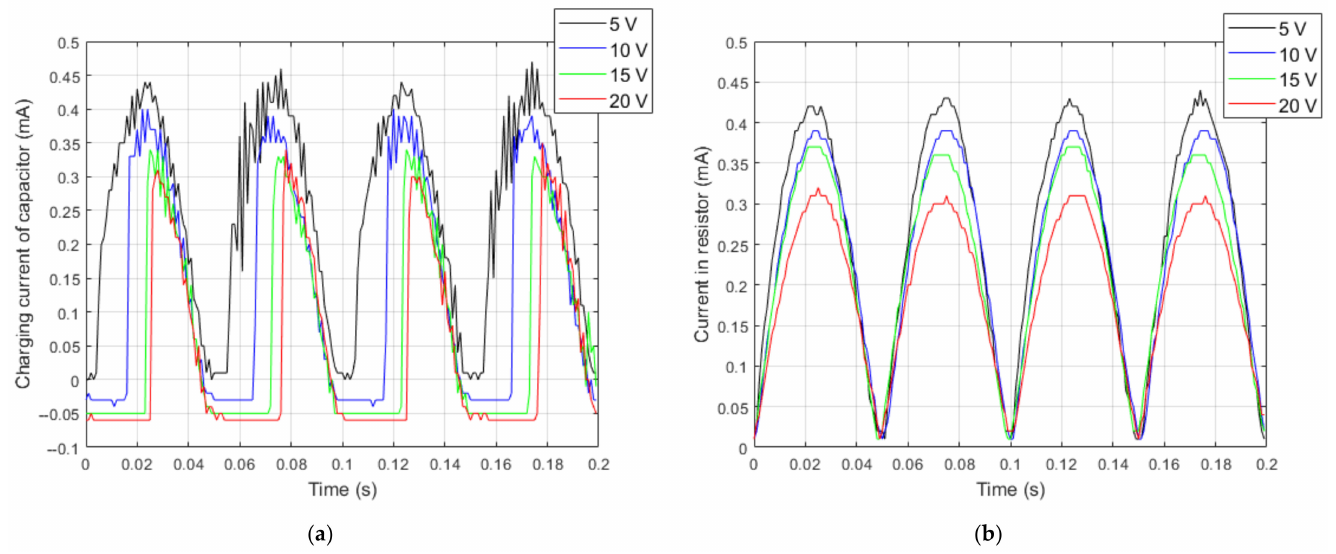
Figure 13. Current courses: ( a ) for capacitive load; ( b ) for resistive load. Comparison between average values of rectified current for the resistive load and average values of the charging current of the capacitor are presented in Figure 14. It should be noted that the difference between these average values of current increased when the voltage increased.